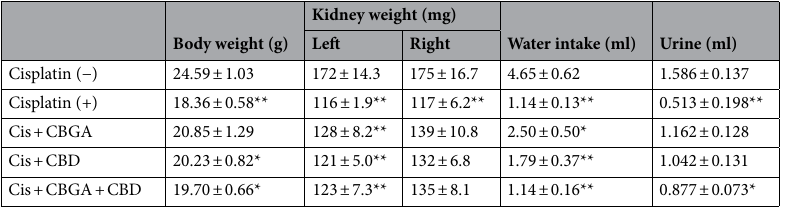
Table 1. Physiological parameters of cisplatin-induced mice at day 3. Mice were sacrificed at day 3 after cisplatin administration and collected kidneys (n = 4–5). *p < 0.05, **p < 0.01 vs. cisplatin (−).